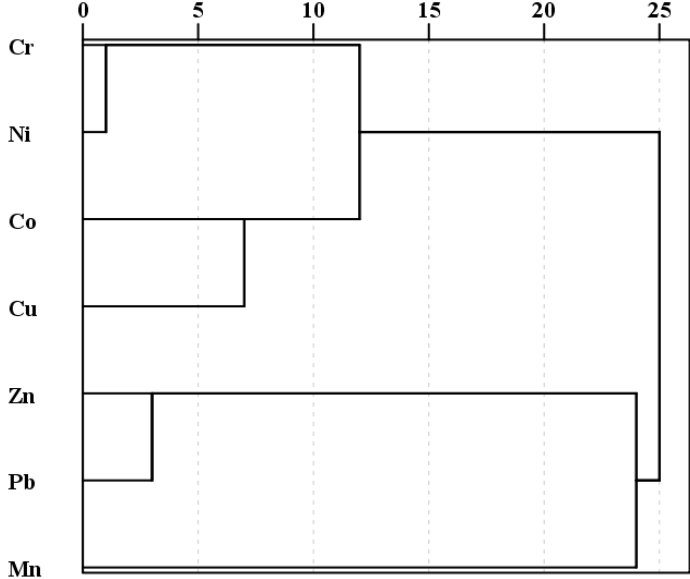
Figure 6. Dendrogram of cluster analysis for heavy metals in the sediment from the Lishui River.